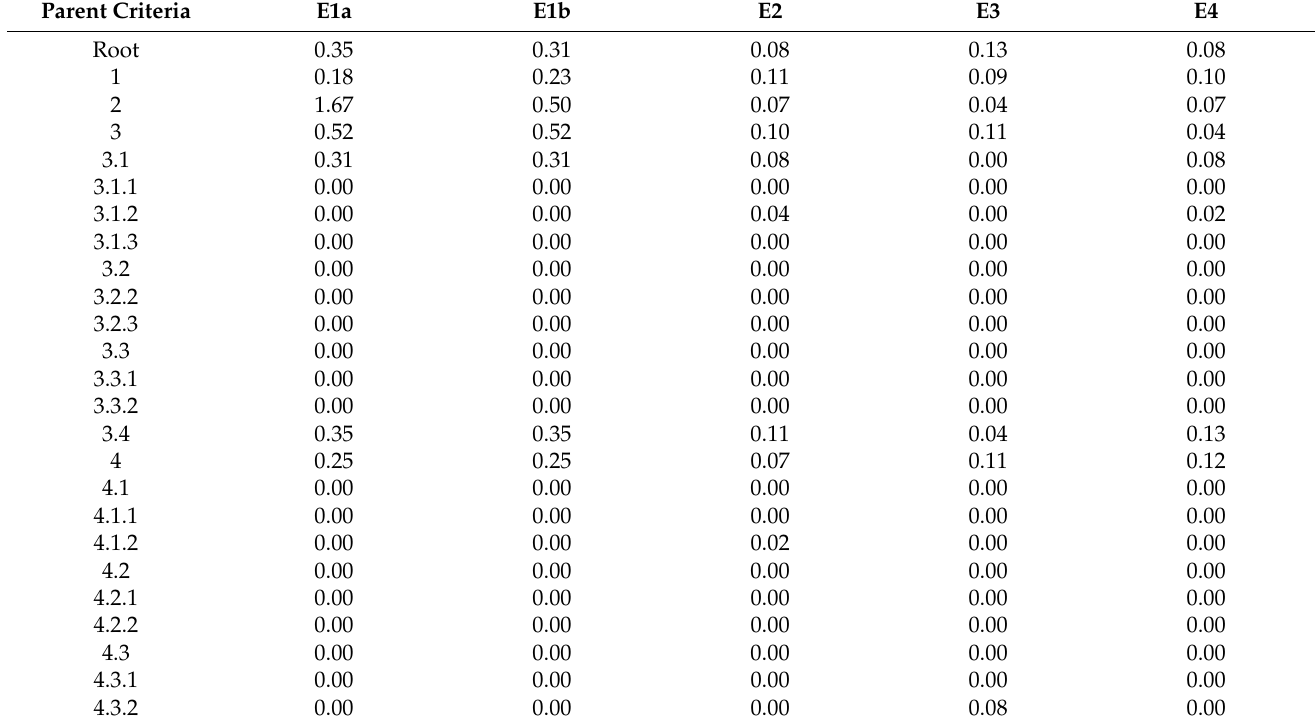
Table 5. Consistency ratio (CR) values for each expert.